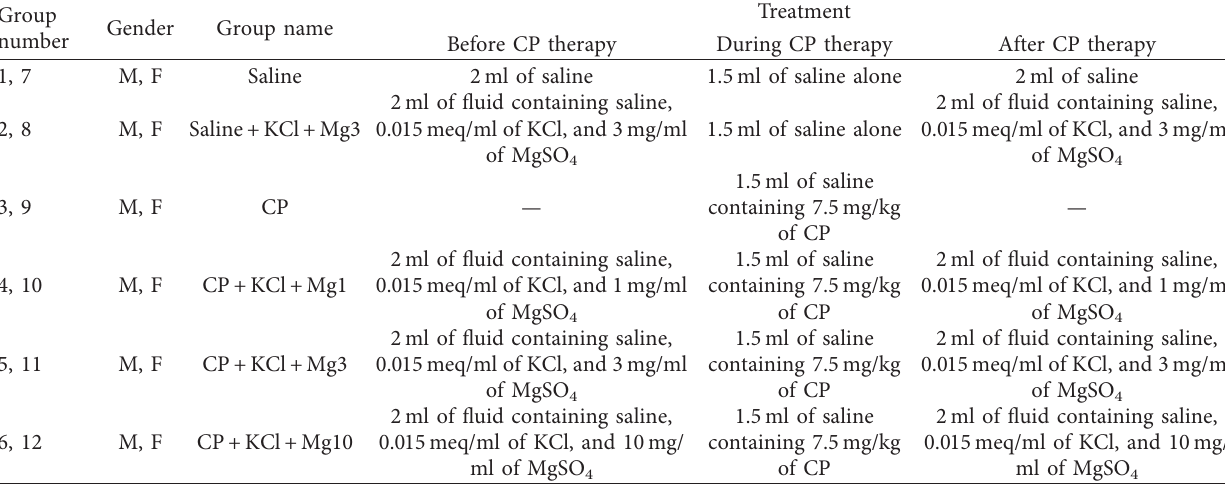
Table 1: The summary of study groups. The duration time of fluid administration before, during, and after CP therapy was 45, 30, and 45 minutes, respectively, using a microinfusion